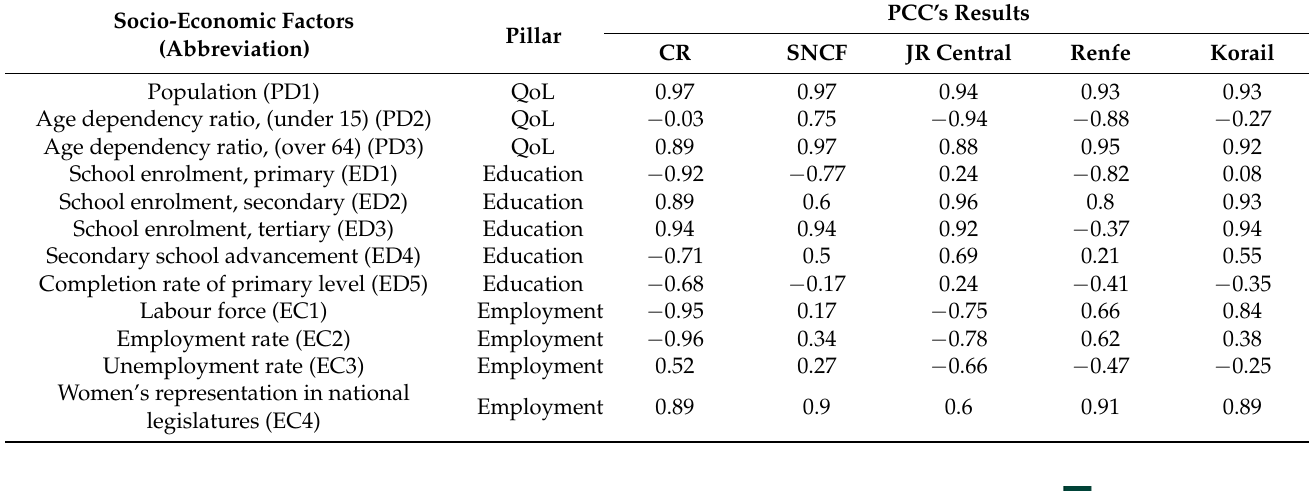
Table 3. The summarisation of PCC results among five HSR networks.